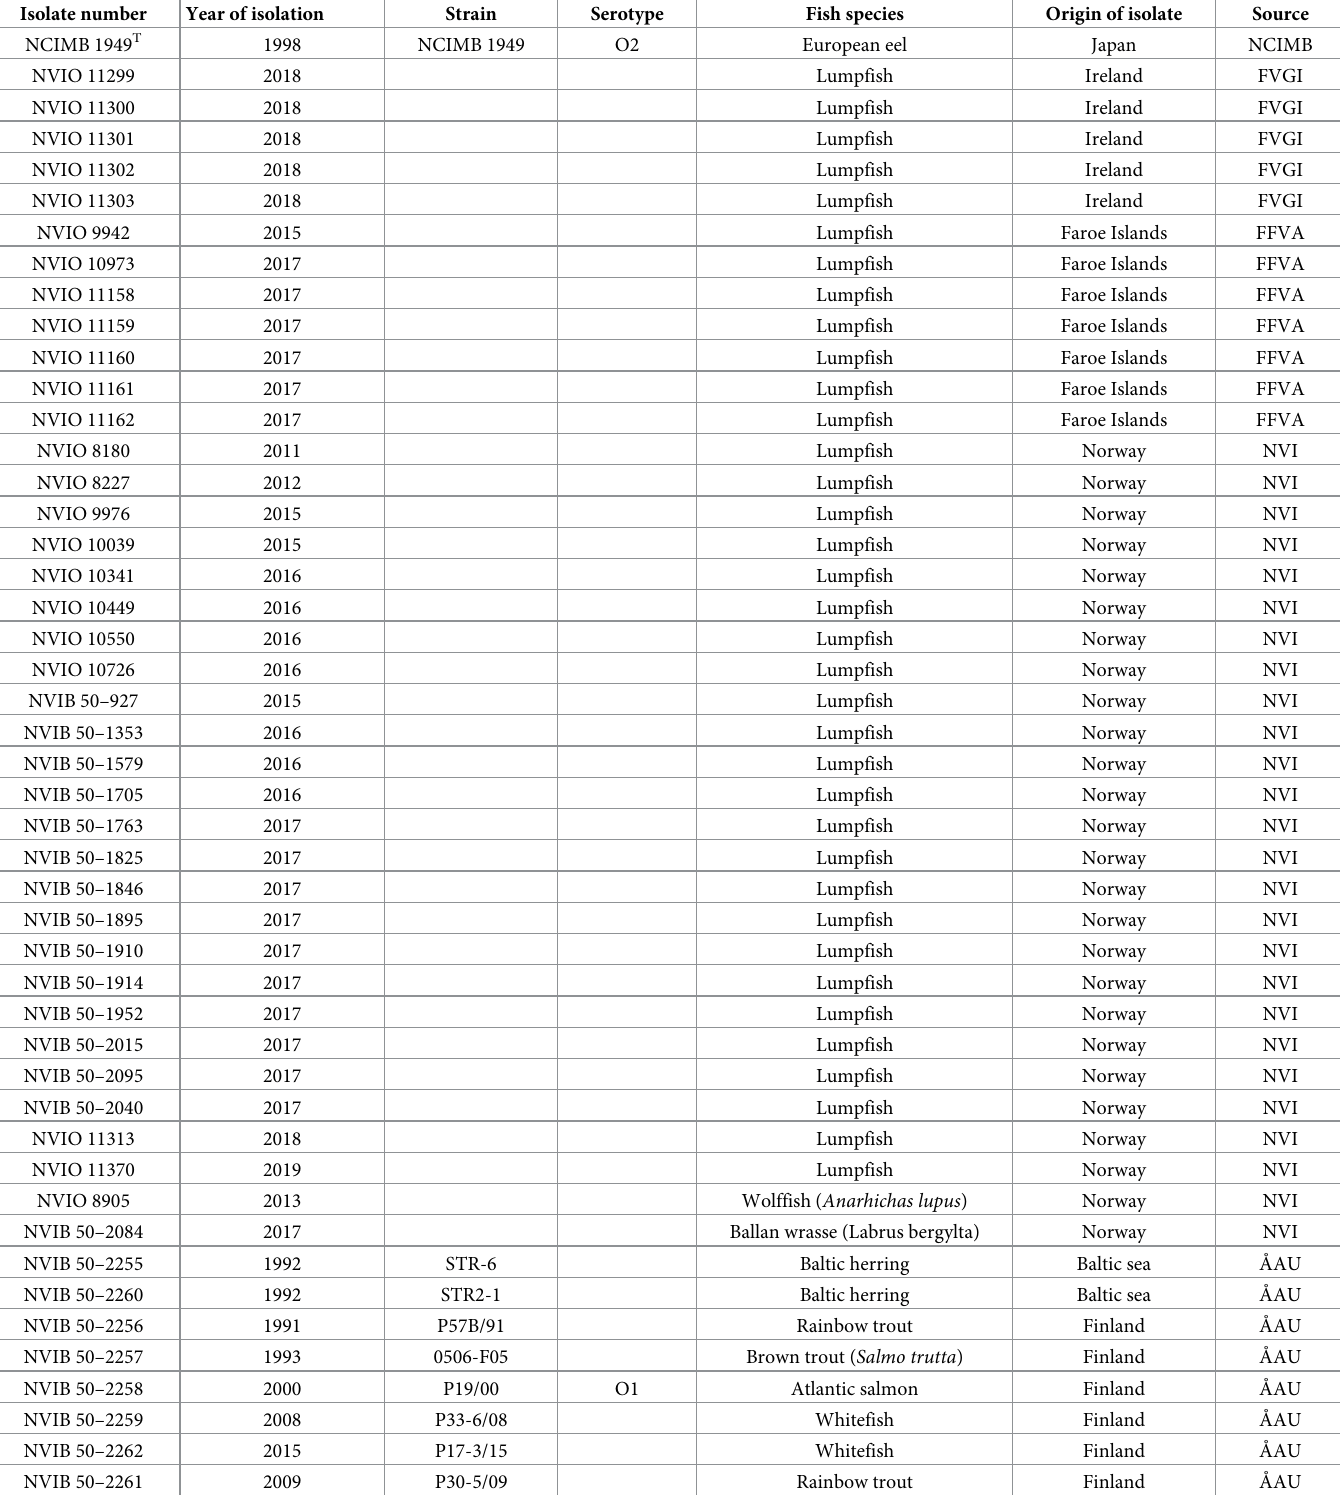
Table 2. Isolates of Pseudomonas anguilliseptica included in this